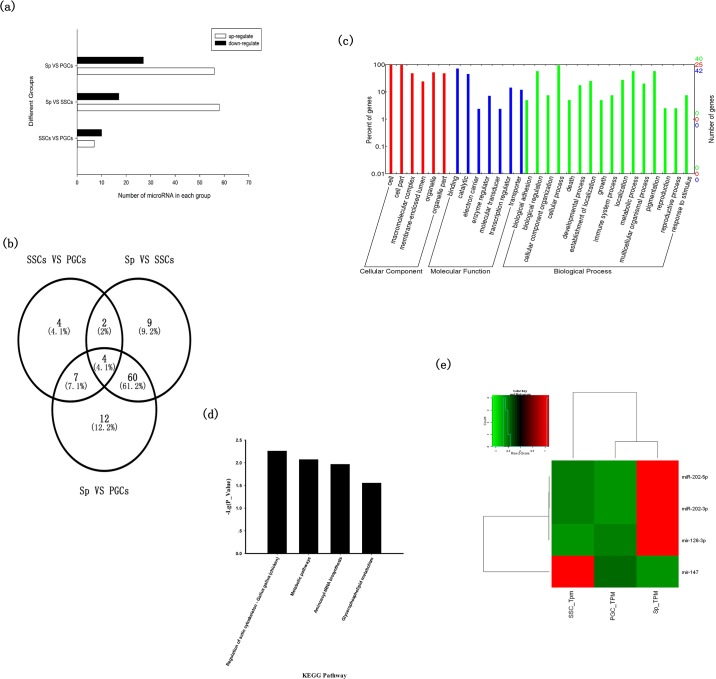
Differentially expressed miRNAs and their target genes.(a) Numbers of miRNAs in each comparison. (b) Venn analysis of the differentially expressed miRNAs in three comparisons. (c) GO analysis of the target genes of four common differentially expressed miRNAs (miR-202-3p, miR-202-5p, miR-147, and miR-126-3p). (d) KEGG analysis of the target genes of four common differentially expressed miRNAs (miR-202-3p, miR-202-5p, miR-147, and miR-126-3p). (e) Expression patterns of four common differentially expressed miRNAs (miR-202-3p, miR-202-5p, miR-147, and miR-126-3p). Red indicates up-regulated; green indicates down-regulated.